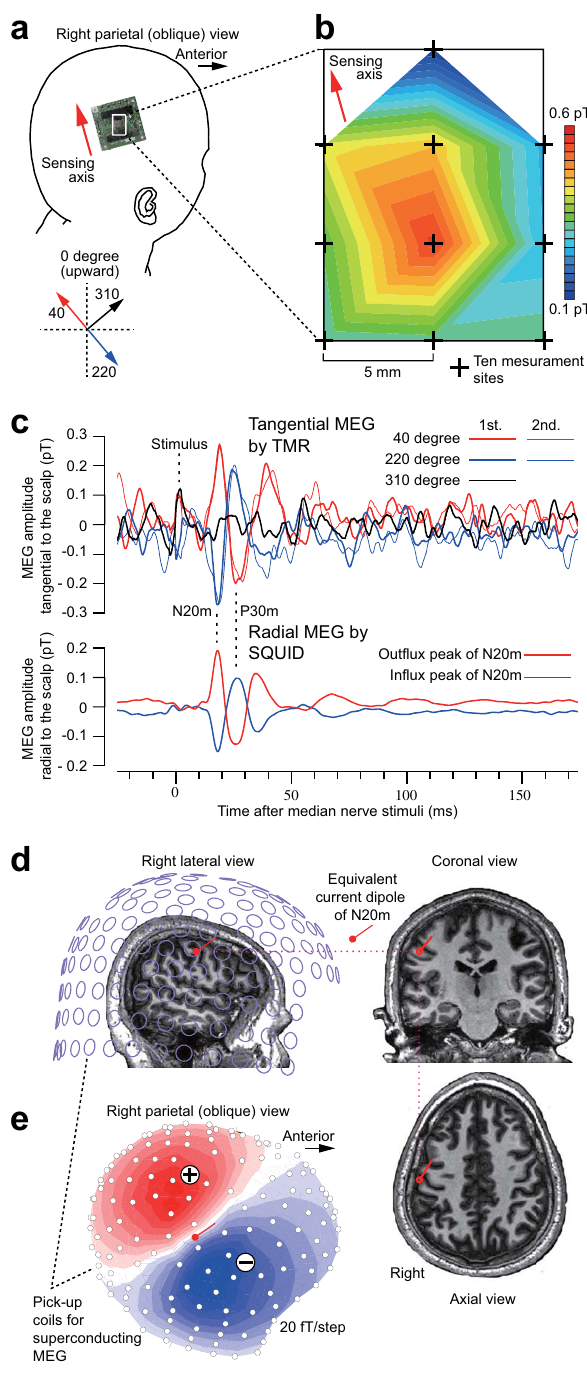
Figure 3. Comparison of tangential MEG using TMR sensors and radial MEG using SQUIDs to measure SEFs in a healthy subject. ( a ) Photograph of a single channel TMR-MEG system placed on the scalp over the right parietal area. Scalp-attached MEG was performed at 2.63 mm from the scalp to the center of the magnetic sensing point. ( b ) Isofield map of N20m, the first SEF component for the left median nerve stimulation, measured at 10 different sites with identical sensing axis of 40 degree counterclockwise from superiorly. Note the spatially steep peak of the N20m. ( c ) Representative SEF waveforms measured by scalp-attached tangential TMR-MEG along three different sensing axes (top) and by the helmet-shaped 200-channel superconducting MEG system (bottom). The 1st and 2nd lines represent two different averaging sessions (N = 9000) to show waveform reproducibility in TMR-MEG for the first (N20m) and second (P30m) components of SEFs comparable to superconducting MEG. ( d ) The helmet-shaped 200-channel radial SQUID-MEG and the equivalent current dipole of N20m superimposed on sagittal, coronal, and axial magnetic resonance (MR) images of the subject. Note the setback distance between the pickup coils and the scalp due to the Dewar vessel containing liquid helium. A red circle and a bar respectively indicate position (on the central sulcus) and orientation (anterior and superior) of the N20m dipole. ( e ) Isofield map of N20m measured by a helmet-shaped 200-channel radial SQUID-MEG. N20m dipole is projected to the coil